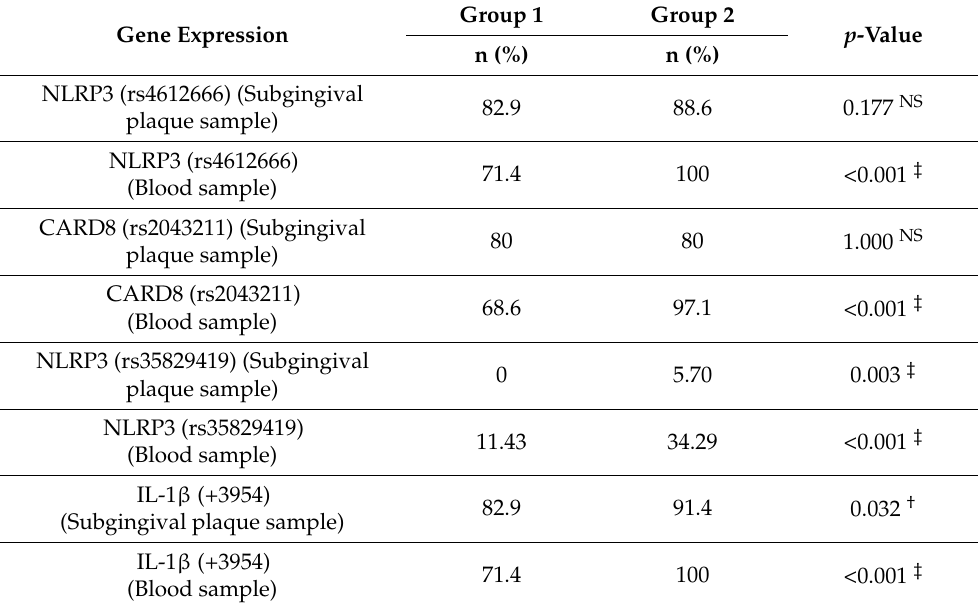
Table 2. Comparison of NLRP3 (rs4612666) and CARD8 (rs2043211) gene expression between